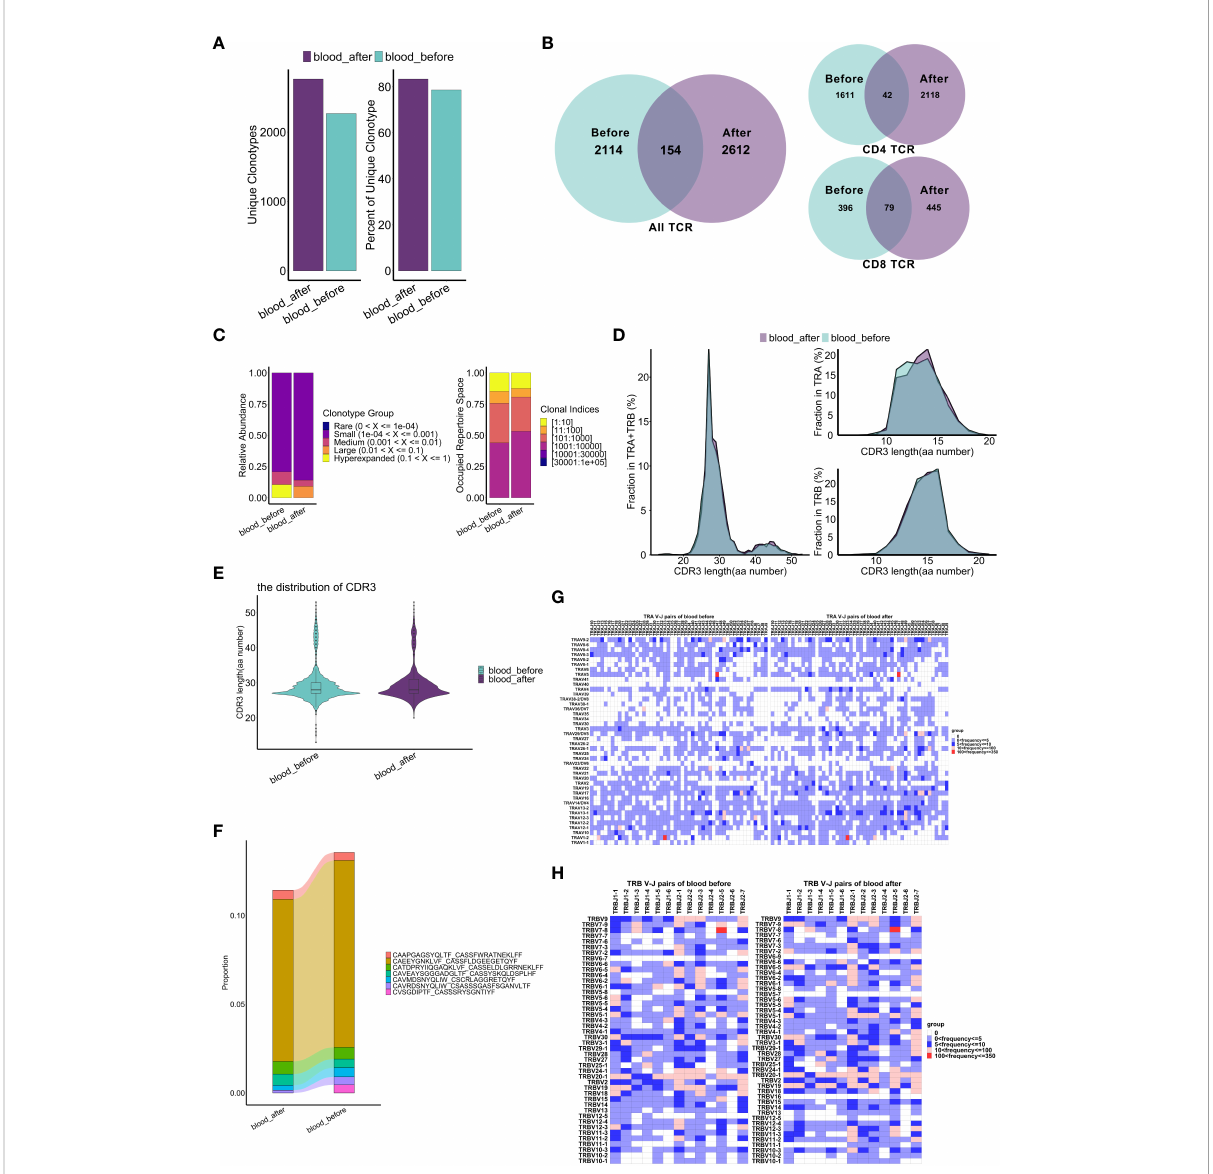
FIGURE 6 Comparative analysis of TCRs pre and post chemotherapy in peripheral blood. (A) Bar graphs show quantity and percentage of unique clonotypes. (B) Venn diagram showing the common and speci fi c TCR of T cells (whole T cells, CD4 + T cells and CD8 + T cells). (C) Clonal homeostatic space representations (clonal space occupied by clonotypes of speci fi c proportions) (left panel) and the relative proportional space occupied by speci fi c clonotypes (right panel) of TCRs across samples. (D) Curve graphs show CDR3 aa length distribution of TCRs (TRA: a chains, TRB: b chains, aa: amino acid). (E) Violin plots show the CDR3 aa length distribution of TCR. (F) Dynamics of dominant CDR3 sequences of TCRs across samples pre and post chemotherapy, colored by the types of dominant sequences. (G, H) Heatmaps show frequency of V-J pairs in a chains (G) and b chains (H) among two samples. The results above are generated by comparison between samples ( blood_before, blood_after